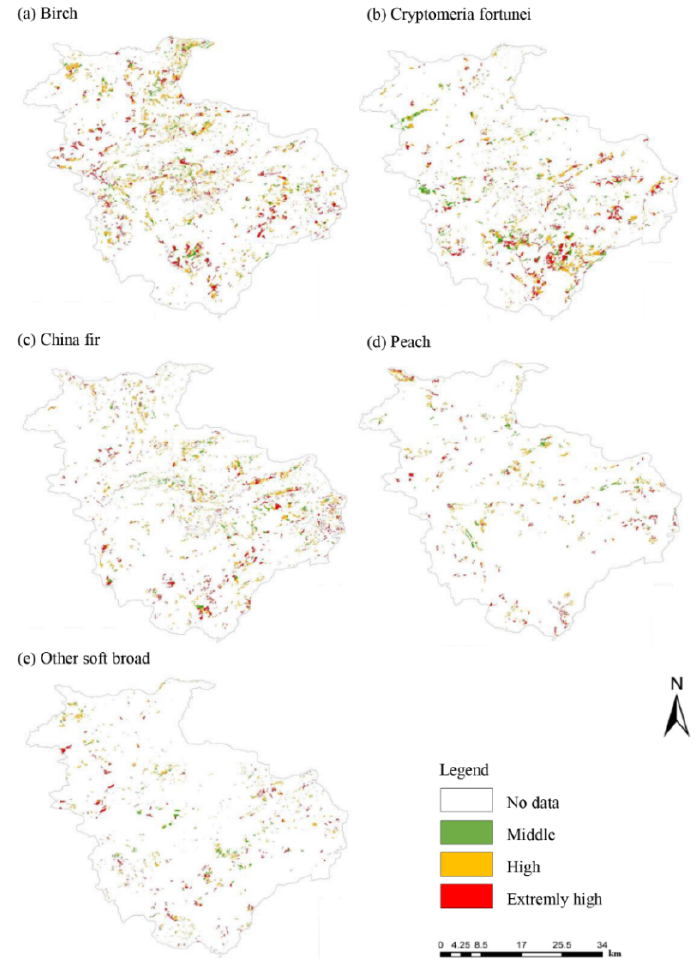
Figure 12. Spatial distribution map of landslide susceptibility of dominant tree species in Nayong County.